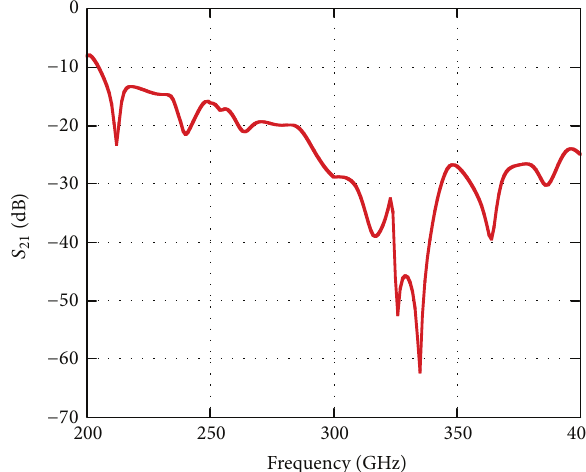
Figure 8: Coupling between the adjacent elements.